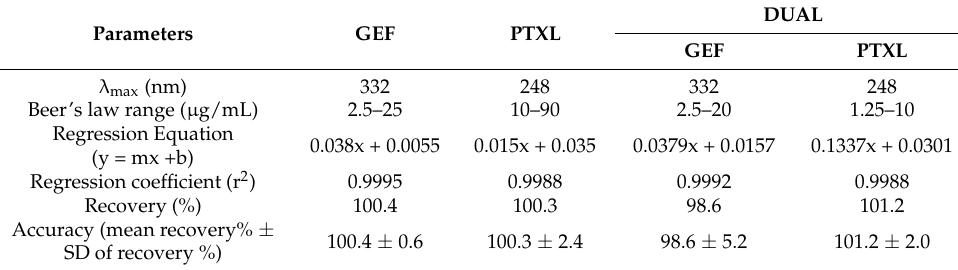
Table A3. Regression characteristics of GEF and